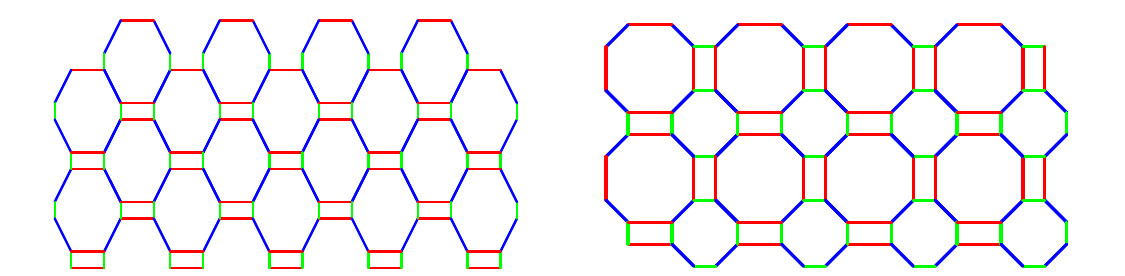
Fig. 41: Each octagon contains edges only from one family either red or green.